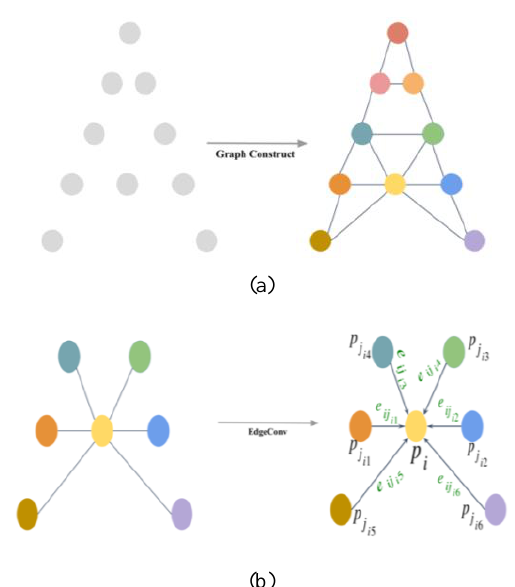
Figure 4. An illustration of the graph construction process and edge features’ learning process in a local region on the contrasted graph. Table 1. Comparison of two datasets: The ArCH Dataset and the S3DIS Dataset. The “N. of Points” column denotes the total number of points in each dataset, except for the points classified as “others” in the ArCH